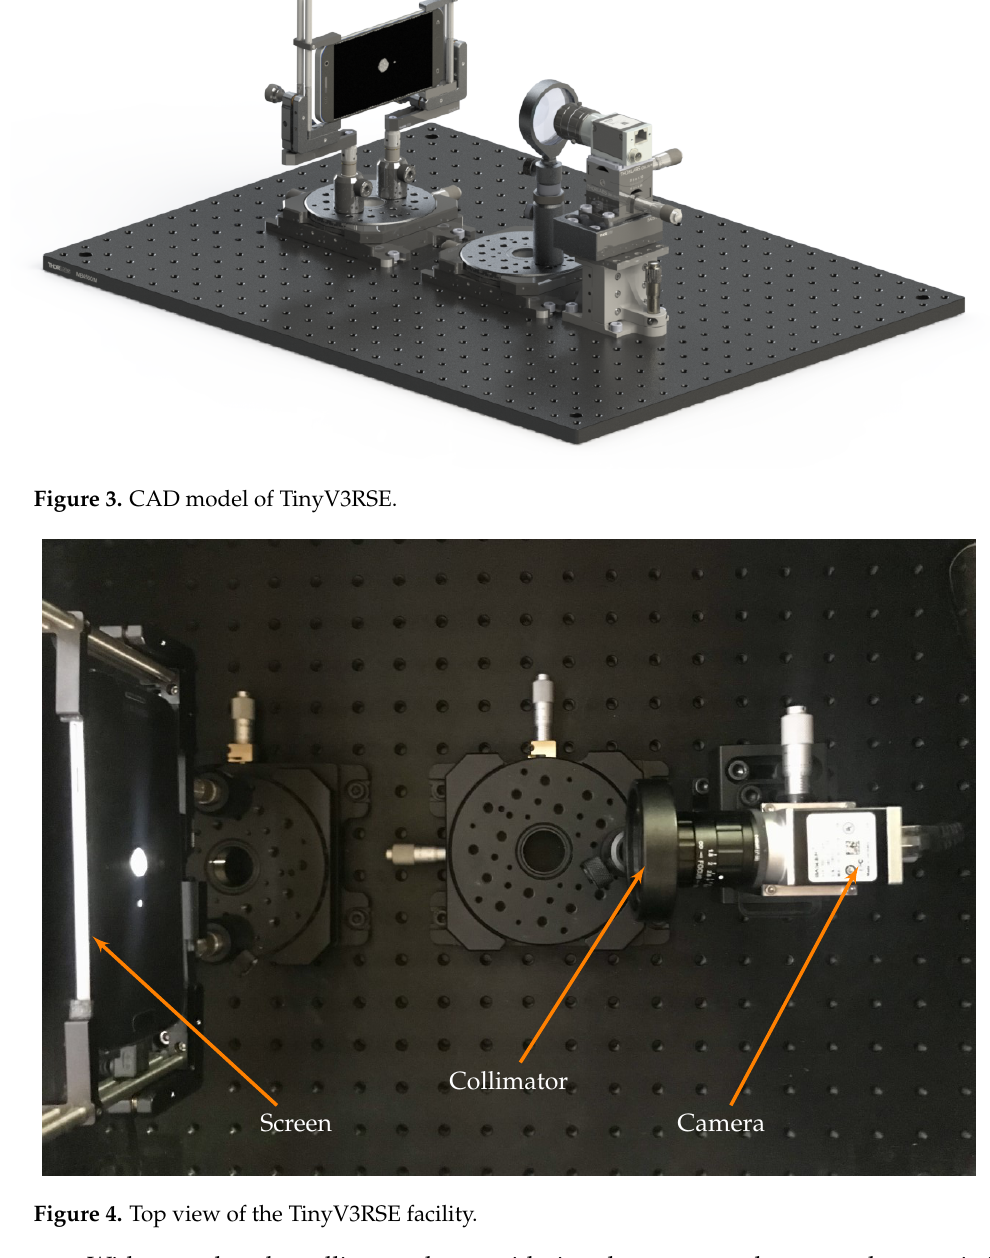
Figure 4. Top view of the TinyV3RSE